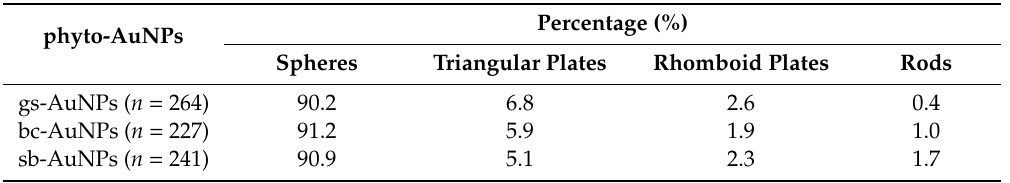
Table 2. Characteristics of the forms of phyto-AuNPs synthesized using leaf extracts from gooseberry, blackcurrant and strawberry (based on TEM data).